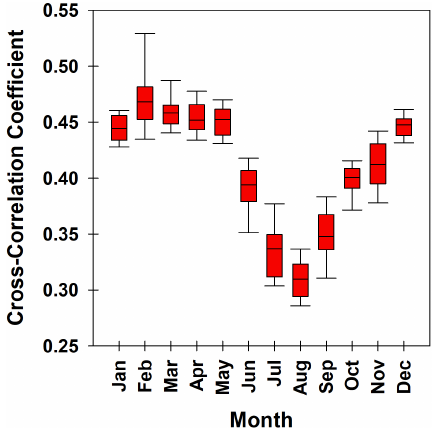
Figure 14. Boxplots of the monthly cross-correlation coefficient based on S1 + RCM SIM from March 2020 to October